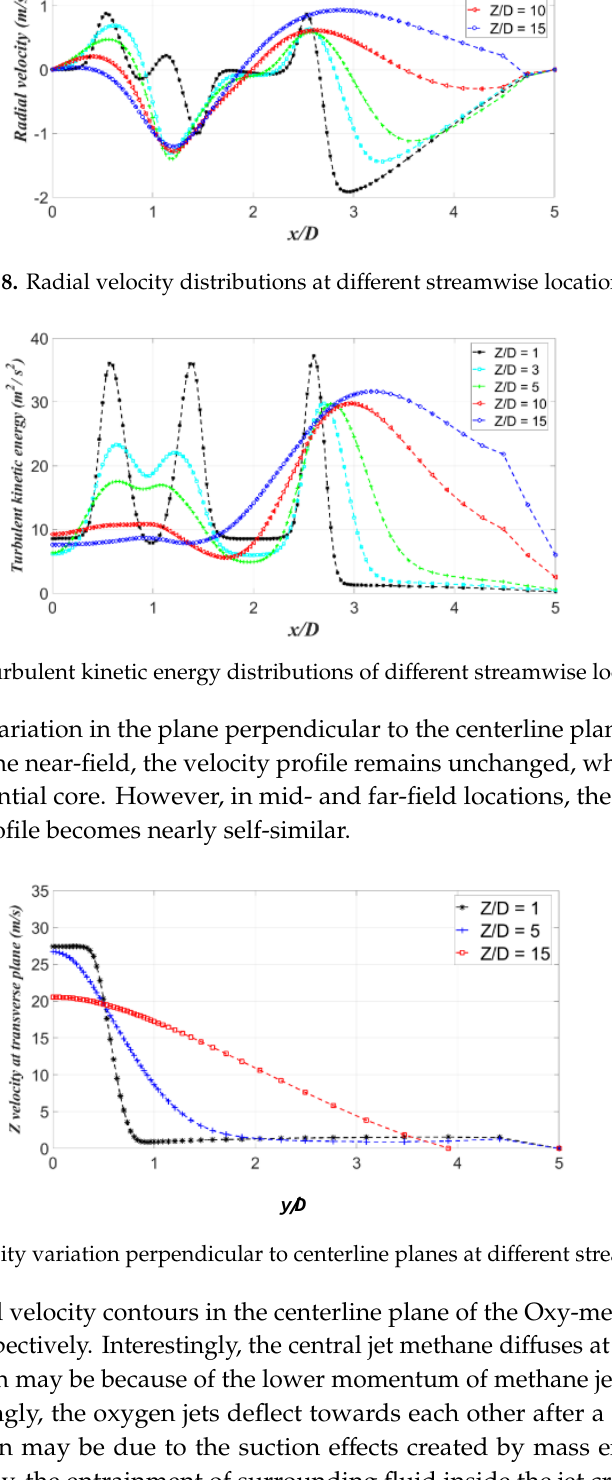
Figure 7. Axial velocity variation in radial direction at different streamwise locations.